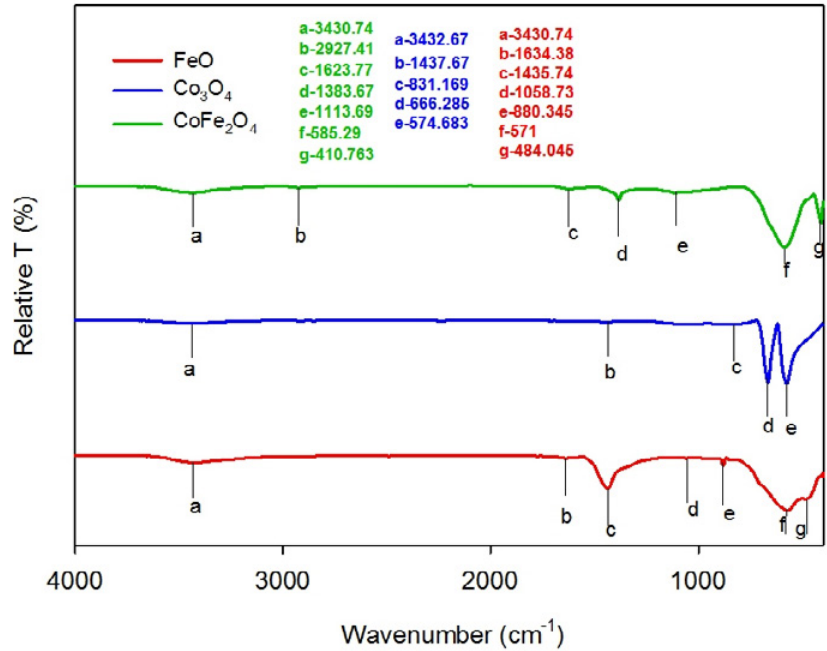
Fig. 5.FTIR spectra of cobalt oxide, iron oxide and cobalt ferrite nanoparticles prepared by wet chemical route after